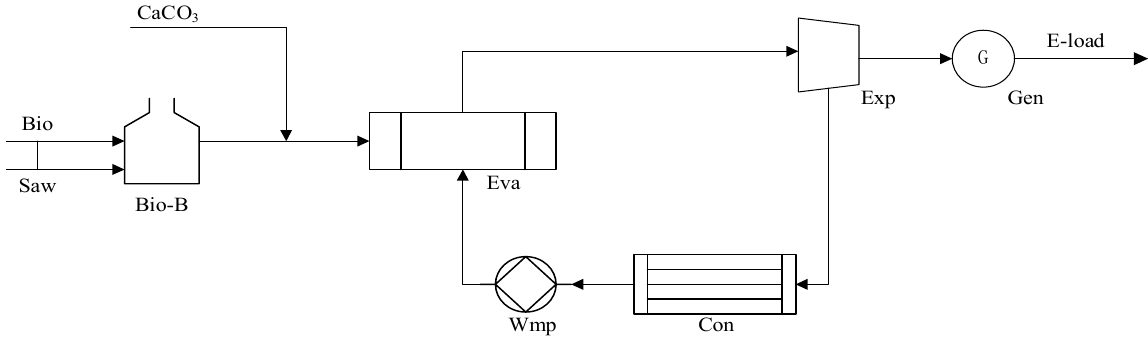
Figure 3. Structure of the biomass ORC power generation system.